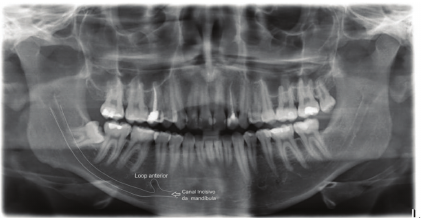
Figure 2: Route of the incisive canal of the mandible [MIC].